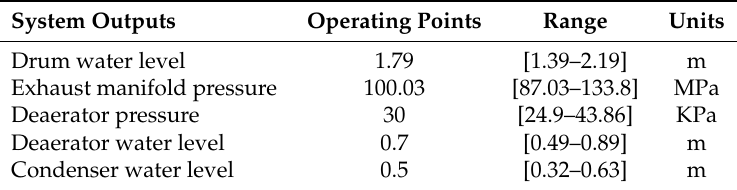
Table 1. System operating points and range.